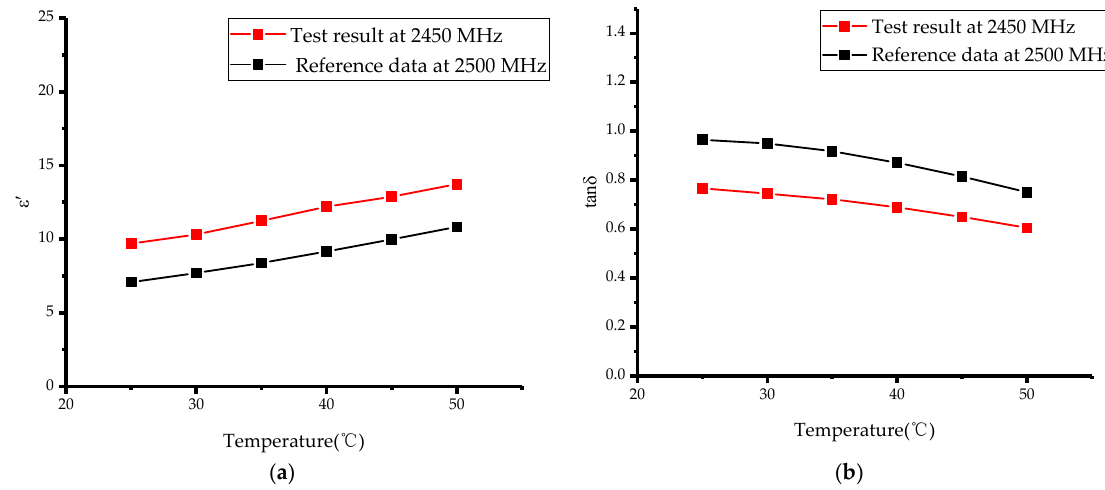
Figure 8. Variations in methanol complex permittivity with temperature: ( a ) ε (cid:48) ; ( b ) tan δ .